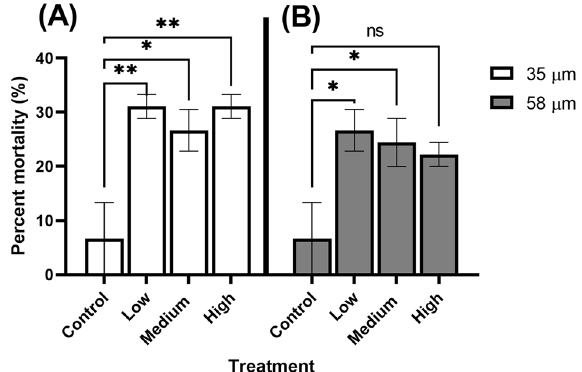
Figure 1. Percent mortality of shrimp from size treatments. ( A ) 35 µm treatment and ( B ) 58 µm treatment. Experimental treatments were statistically compared to control treatments. *Denoted p-value that is < 0.05. **denotes p-values that is < 0.01. ns = not